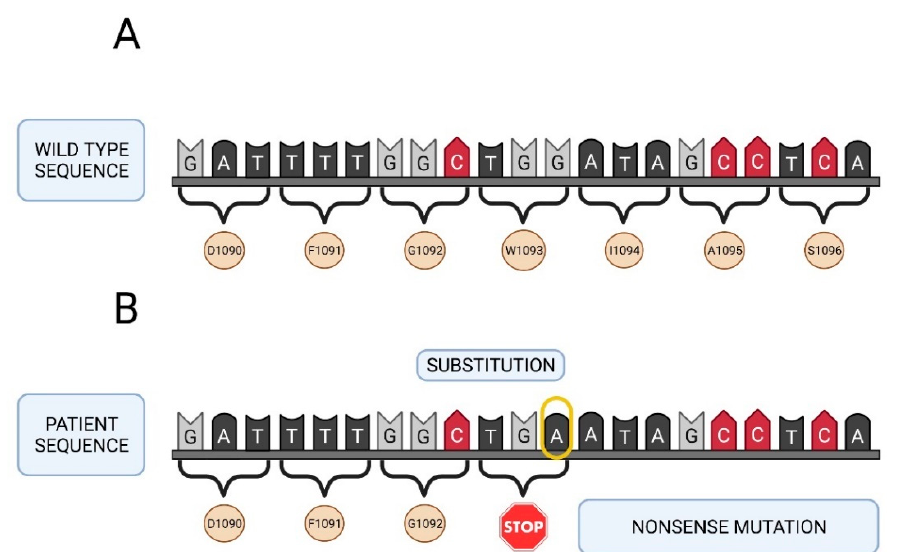
Figure 3. Genetic map of the F5 gene of patient A. ( A ) Native sequence. ( B ) Sequence of the patient with the Trp1093* mutation (premature stop codon, nonsense mutation). Created in Biorender.com (accessed on 6 September 2021).